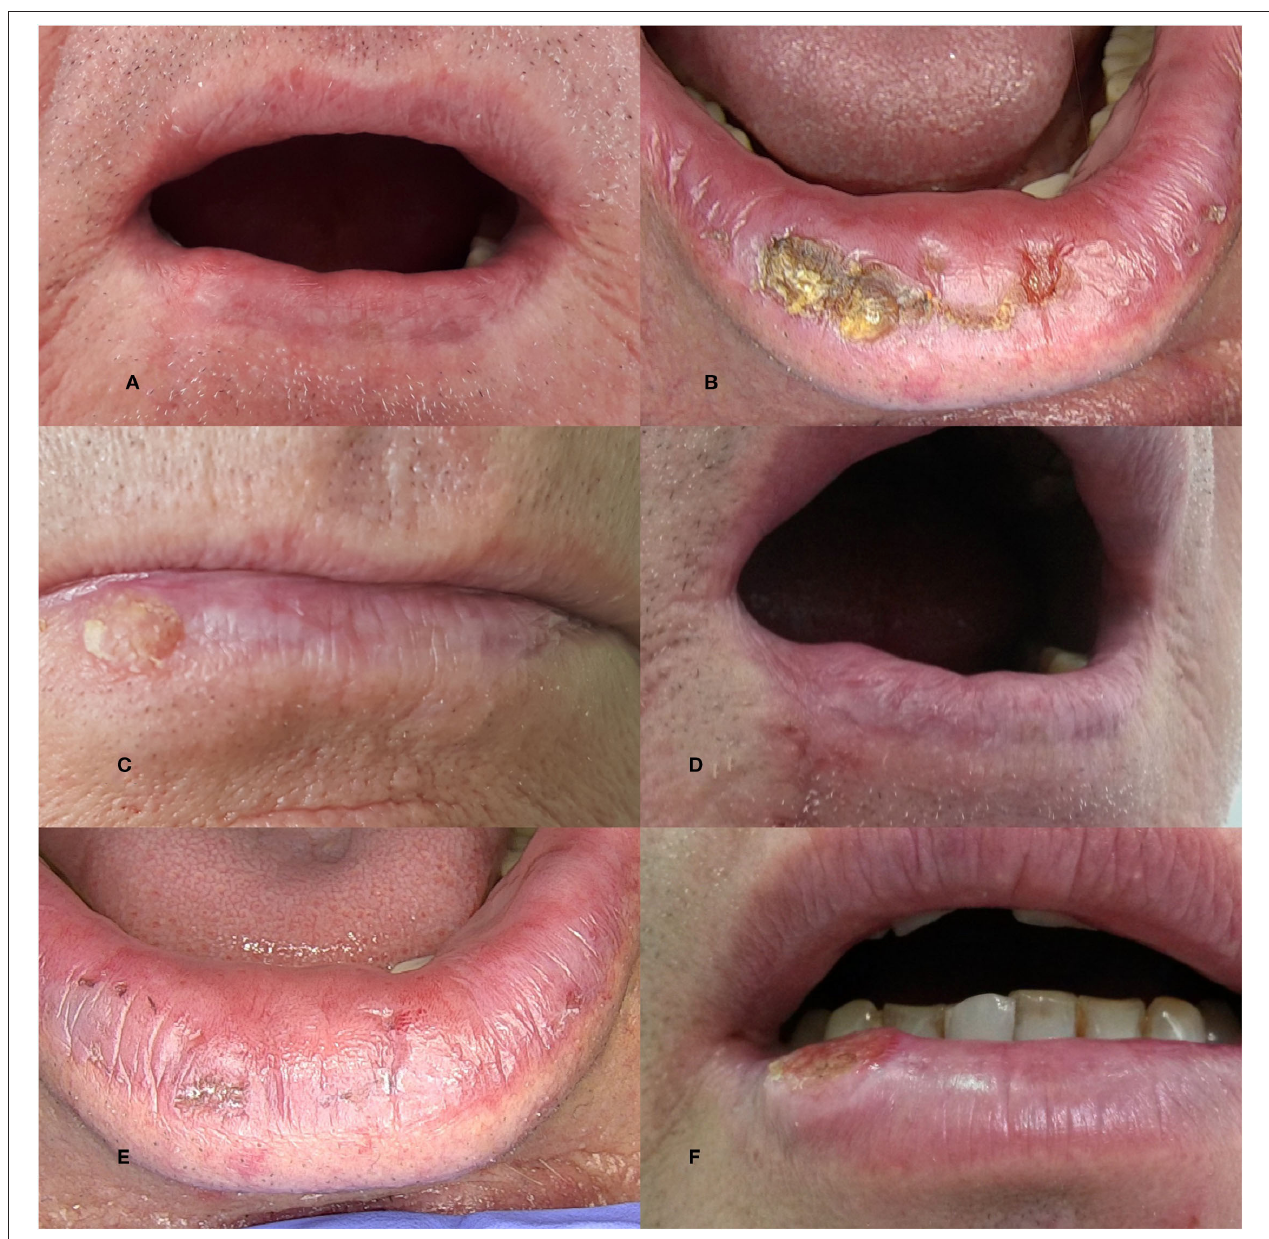
FIGURE 1 | The clinical picture of actinic cheilitis (AC) C: (A) Xerosis; (B) Hyperkeratosis; (C) Mottled appearance; (D) Blurred demarcation of the vermilion border; (E) Fissures; (F) Plaque.